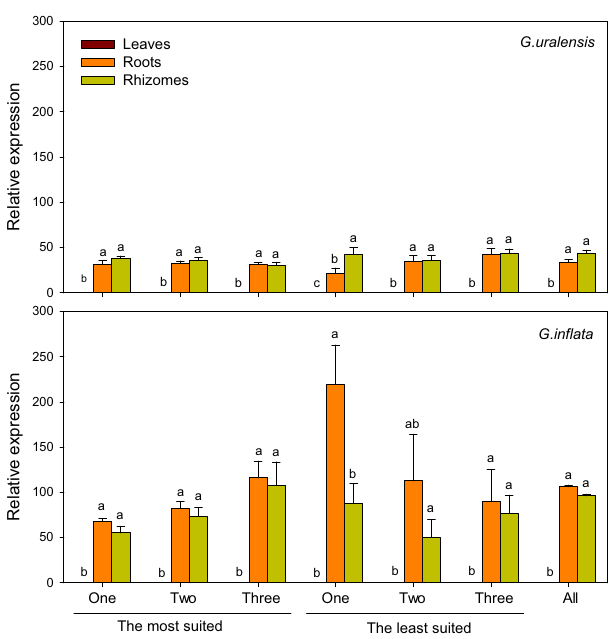
Figure 5. Validation of the recommended reference genes. Expression profiles of β-AS gene among different tissues were investigated using seven different normalization factors. The most suited, the top two most suited, the top three most suited, the least suited, the top two least suited, the top three least suited, and all the candidate reference genes. Bars represent the means ± standard error of biological replications. Different letters indicate significant differences ( P <